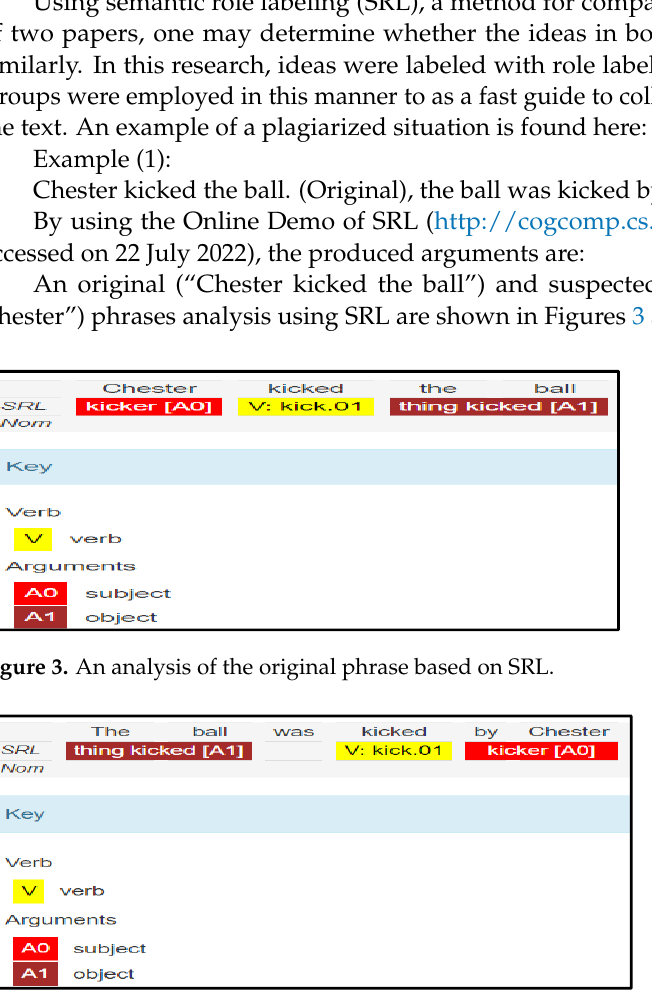
Figure 4. An analysis of the suspected phrase based on SRL.